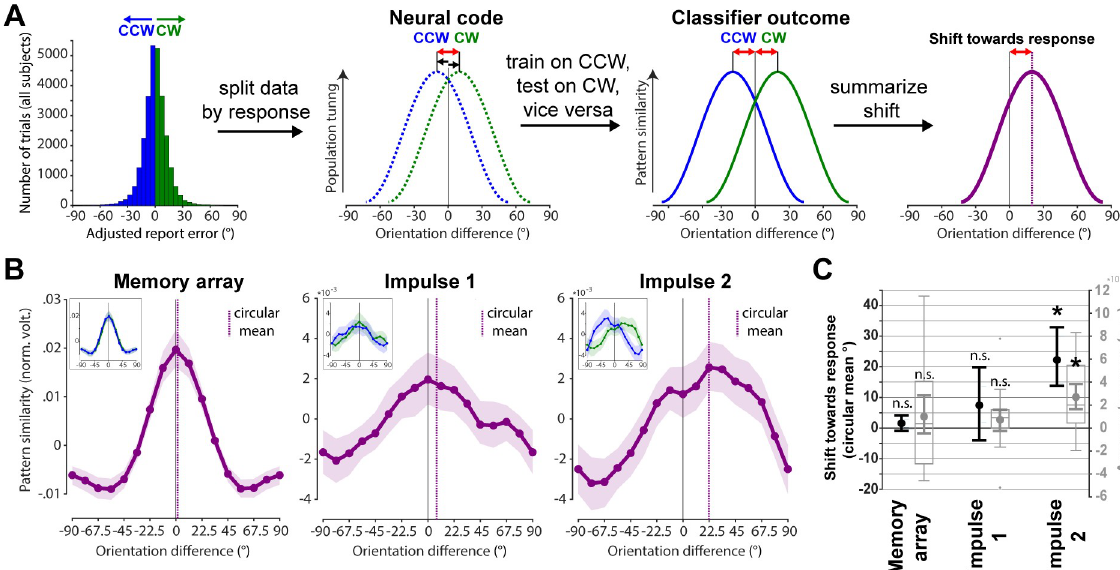
Fig 7. Response-dependent training and testing demonstrates drift. Schematic and results. (A) Testing for shift towards response by first splitting the neuroimaging data into CW and CCW data sets and training on CW trials and testing on CCW trials, and vice versa. Given an actual shift, the shift of the resulting orientation reconstruction will be doubled, since training and testing data are shifted in opposite directions. (B) Results of schematised approach in (A). Average orientation similarity profiles such that a rightward shift reflects a shift towards the response (purple) at each event. Purple vertical lines show circular means of the similarity profiles. Insets show orientation similarity profiles for CCW (blue) and CW (green) responses separately. Error shadings are 95% CI of the mean. (C) Group-level (circular mean) and participant-level (asymmetry score) shifts towards the response of each response-dependent similarity profile are shown in black and grey, respectively. Error bars are 95% CI of the mean. Data available at osf.io/cn8zf. a.u., arbitrary units; CCW, counterclockwise; CW, clockwise; norm. volt., normalised voltage; n.s., not